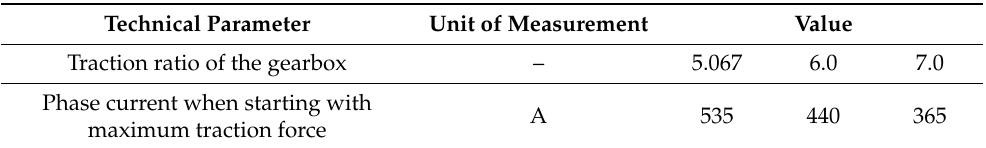
Table 7. Values of the phase current of the asynchronous electric motor when starting with the maximum traction